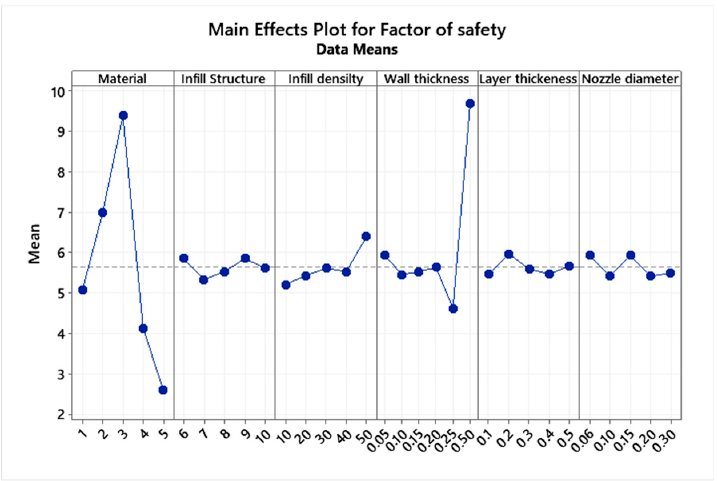
Figure 6. Main effects plot for the factor of safety .